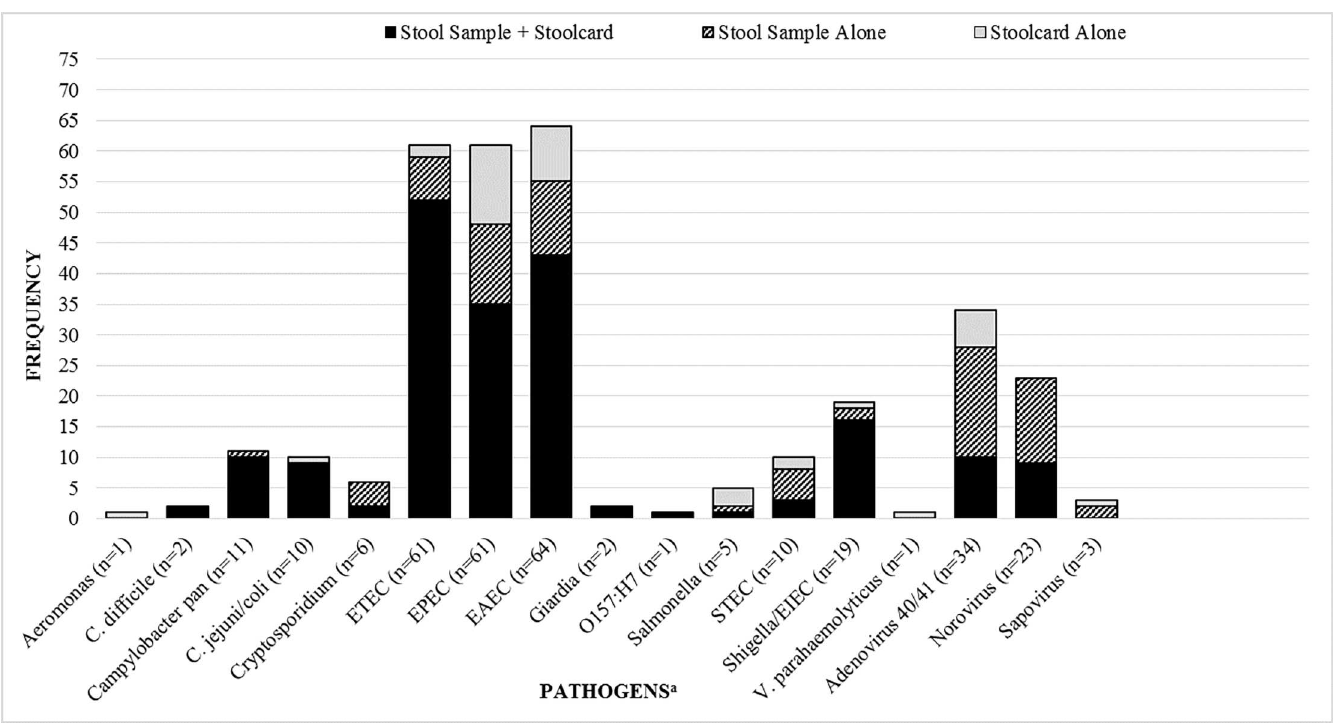
Fig 2. Overall distribution of pathogens in the 187 paired stool and FTA card samples from subjects with travelers’ diarrhea enrolled in the TrEAT TD clinical trial. Footnote for Fig 2. a Totals in horizontal axis represent total number of subjects positive for a pathogen on either a stool sample, Whatman FTA card or both. No samples were positive for Cyclospora, Entamoeba histolytica , astrovirus, and rotavirus and are therefore not